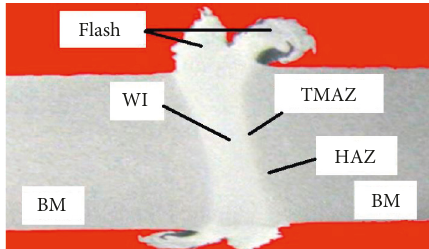
Figure 8: Macrograph of optimized LFW-Ti6Al4V alloy